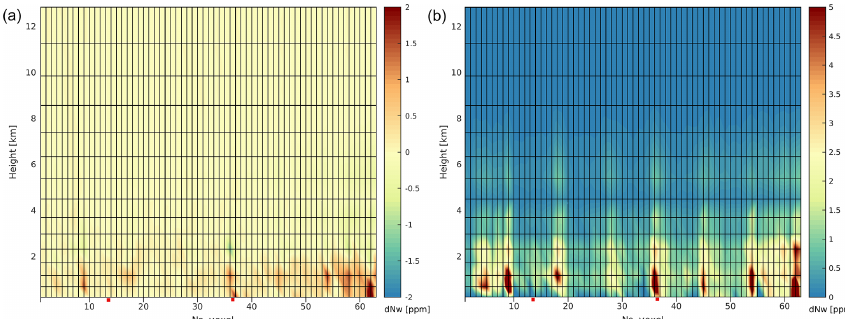
Figure 4. Bias (a) and standard deviation (b) of the differences in wet refractivity (ppm) between TUW set0 and TUW set2. Analysed period: 29 May–14 June 2015 (68 epochs). Red squares denote location of the RS stations.